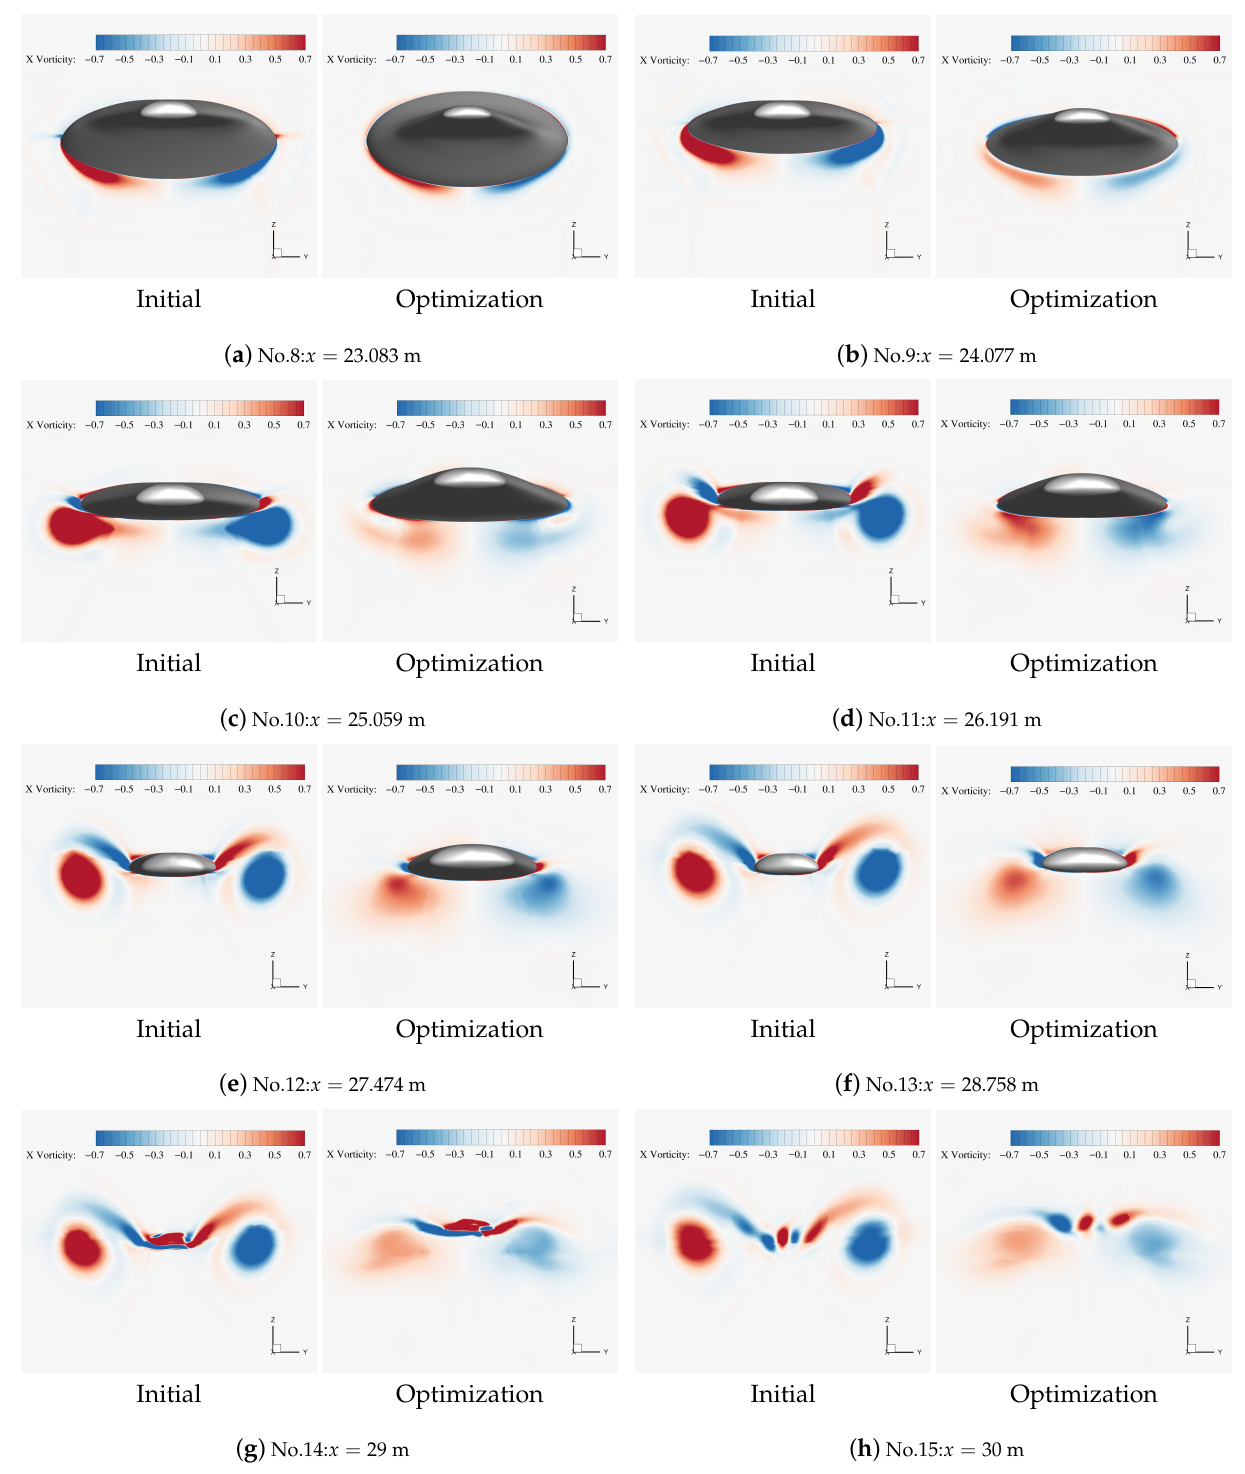
Figure 18. Comparison of x vorticity in eight cross-sectional positions of military